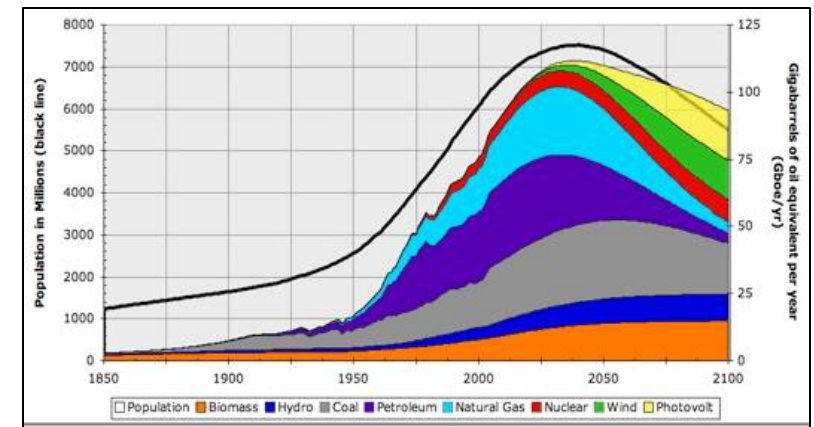
Fig. 5. World energy production. [3]